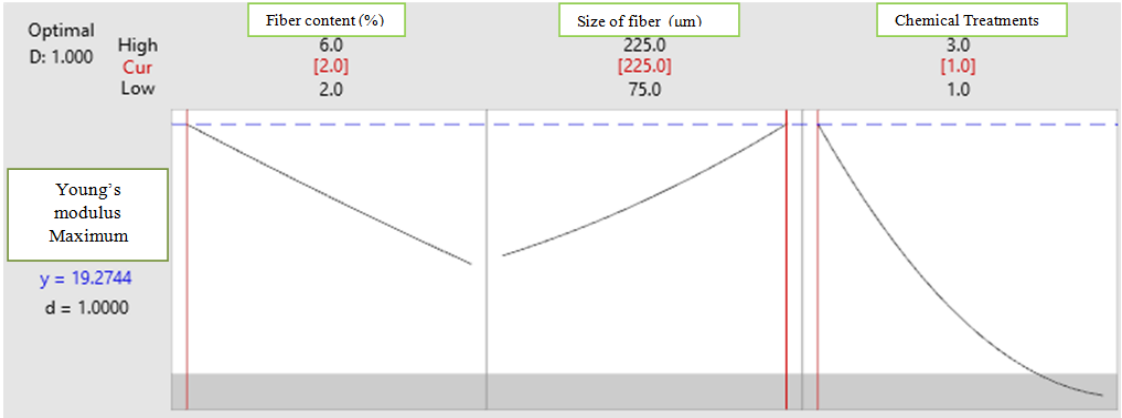
Figure 14. Response optimization plot for Young’s modulus.